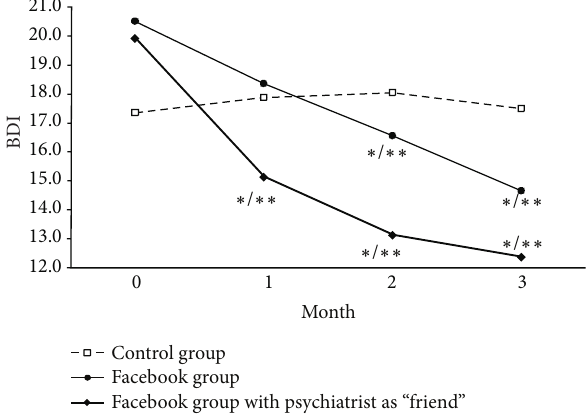
Figure 2: ∗ 𝑃 < 0.05 compared to baseline; ∗∗ 𝑃 < 0.05 compared to control group. 𝑃 values from ANCOVA with baseline values as covariate.